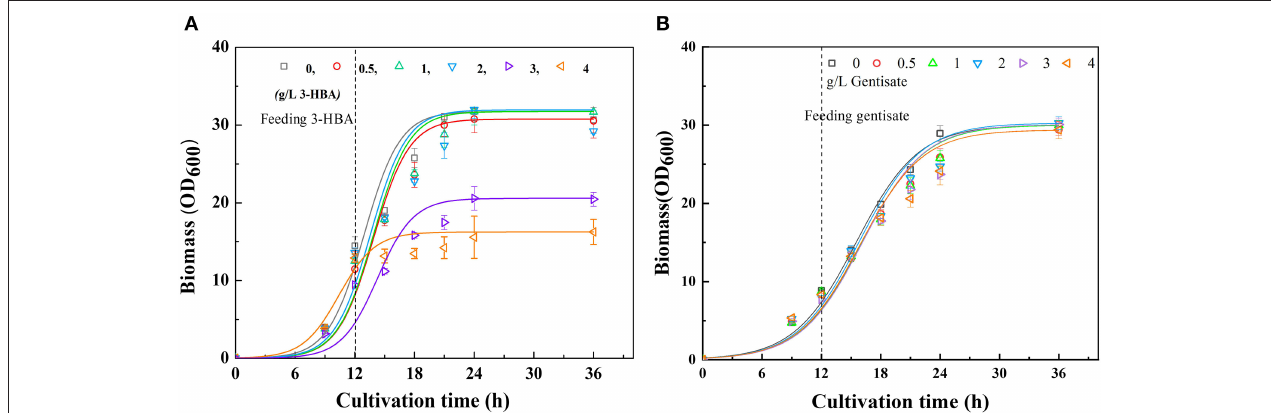
FIGURE 2 | Culture profiles of P . chlororaphis in KB medium supplemented with 0–4g L − 1 3-HBA or gentisate at 12h. (A) Time courses of a bacterial cell growth when supplemented with 0–4g L − 1 3-HBA, (B) Time courses of a bacterial cell growth when supplemented with 0–4g L − 1 gentisate. Data are presented as the mean ± standard deviation of three independent experiments ( n = 3).